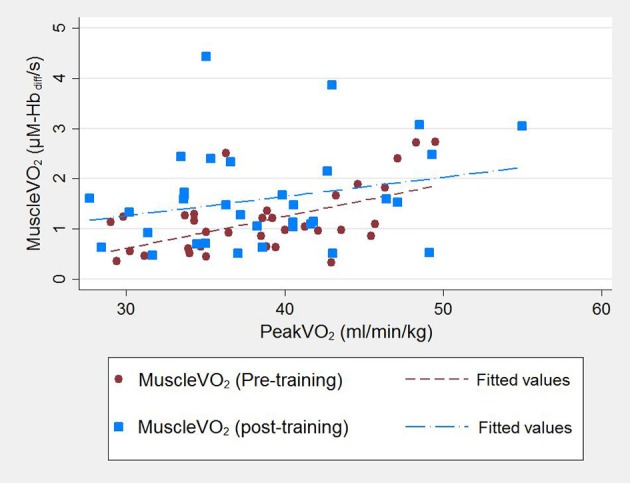
Correlationbetween cardio-pulmonary peakV˙O2 and post-exercise muscleV˙O2 for 27 participants assessed pre-training and post-training. Participant data pre-training are represented by red circles and a red line of best fit and post-training by blue squares and a blue line of best fit.